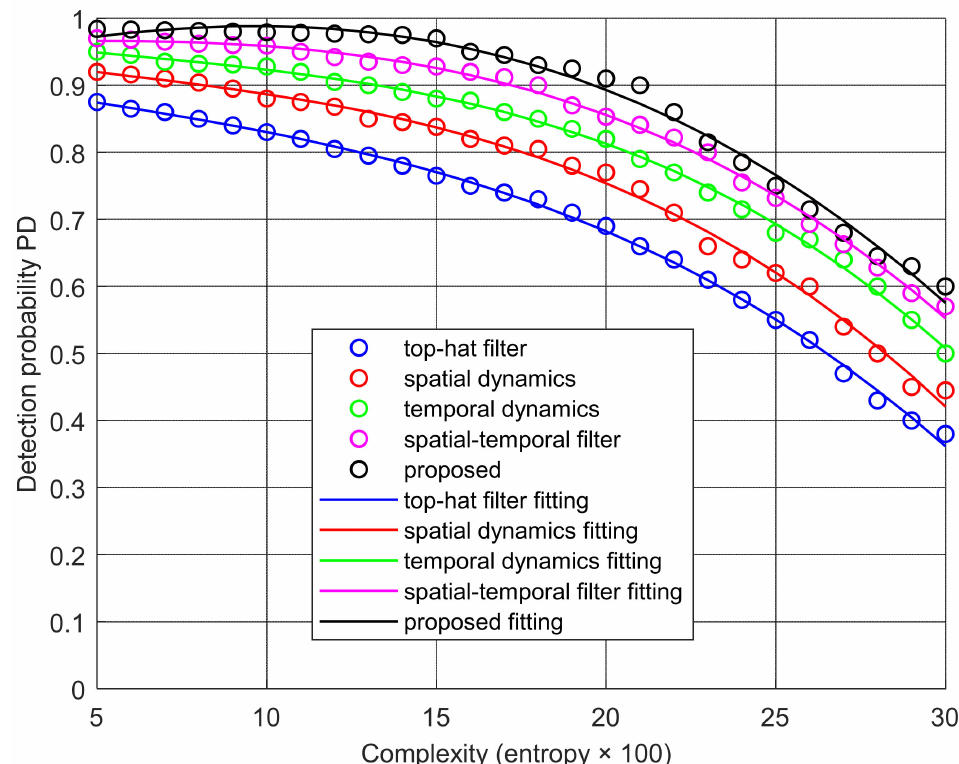
Figure 17. Detection probability versus sea complexity.